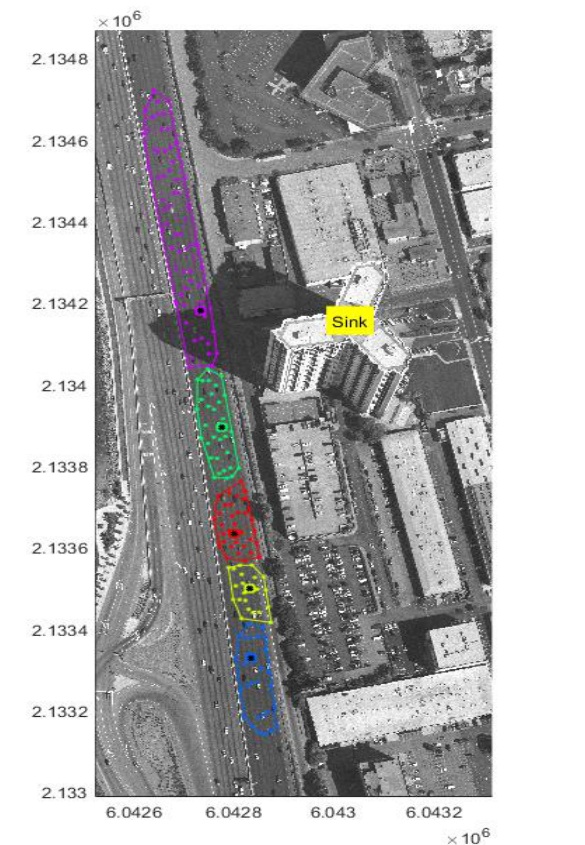
Figure 2. The best clustering result obtained by applying the FCM algorithm over 100